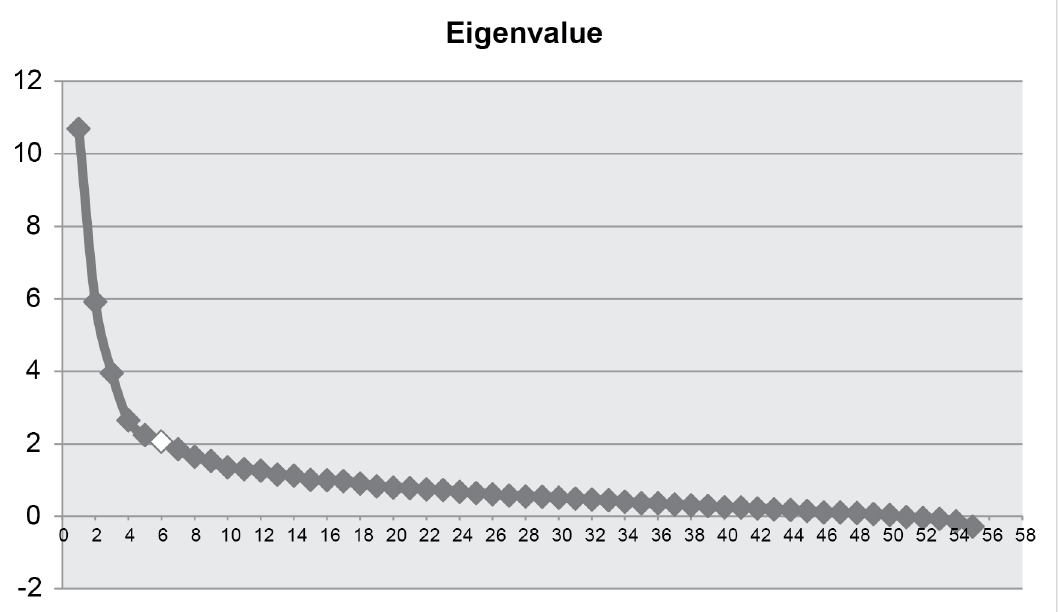
Fig 1. Exploratory Factor Analysis (EFA) eigenvalues . Legend: Horizontal axis: number of factors; vertical axis: factor eigenvalues . The six-factor solution provided the most parsimonious and interpretable description.